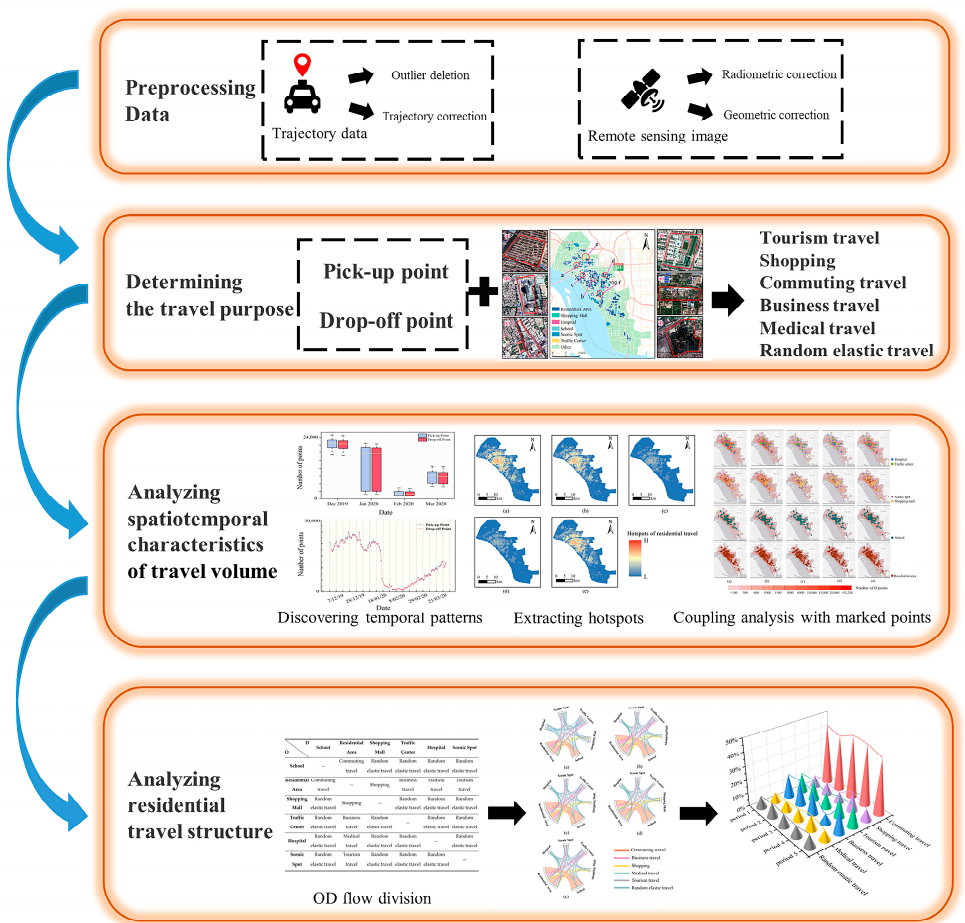
Figure 2. Framework of this paper. Marked points represent the points with urban functional area attributes; OD flow represents the origin–destination